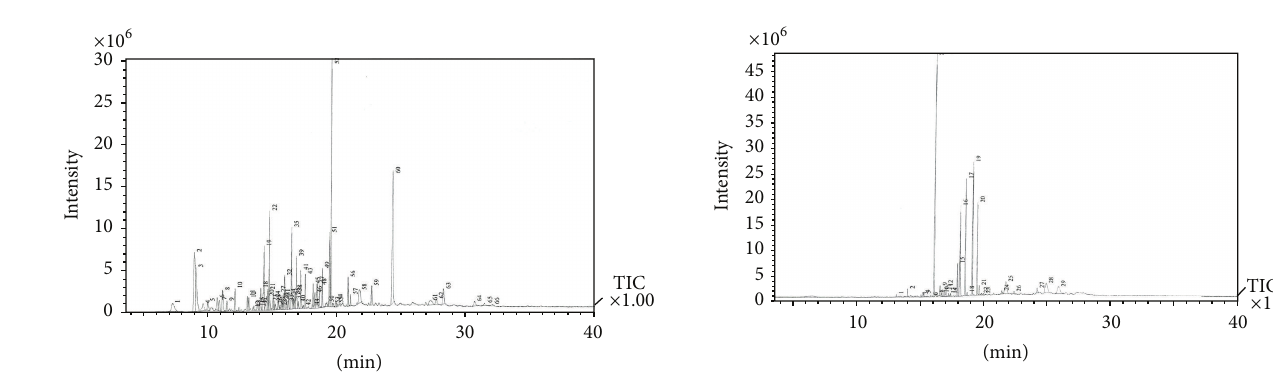
Figure 2: Gas chromatography-mass spectrometry profile of Psid- ium guajava leaf extract.